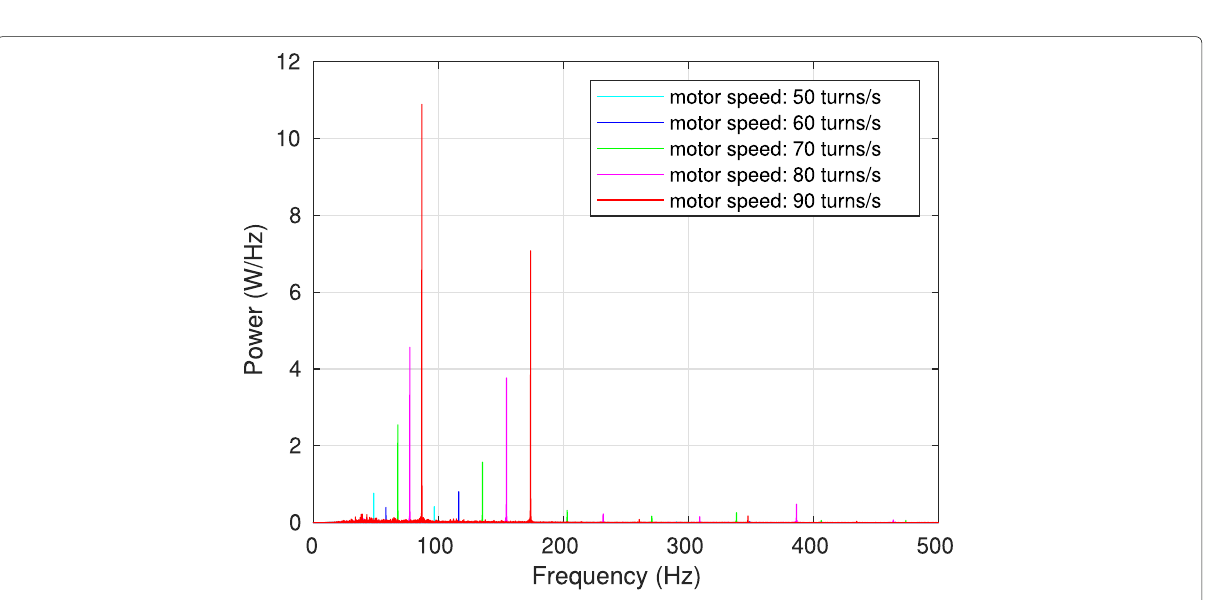
Fig. 3 Frequency bins of ego-noise for different rotor